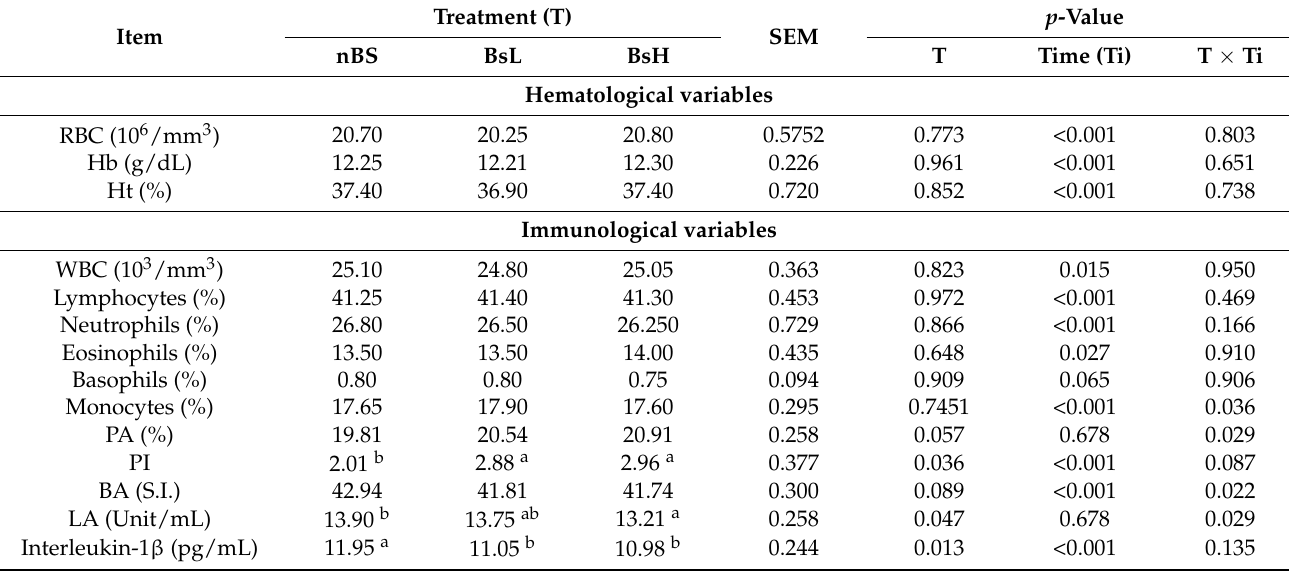
Table 2. Hematological and immunological variables for transitioning goats that received 0 (nBS), 2 (BsL), and 4 (BsH) g of Boswellia sacra resin daily from week 2 prepartum to week 7